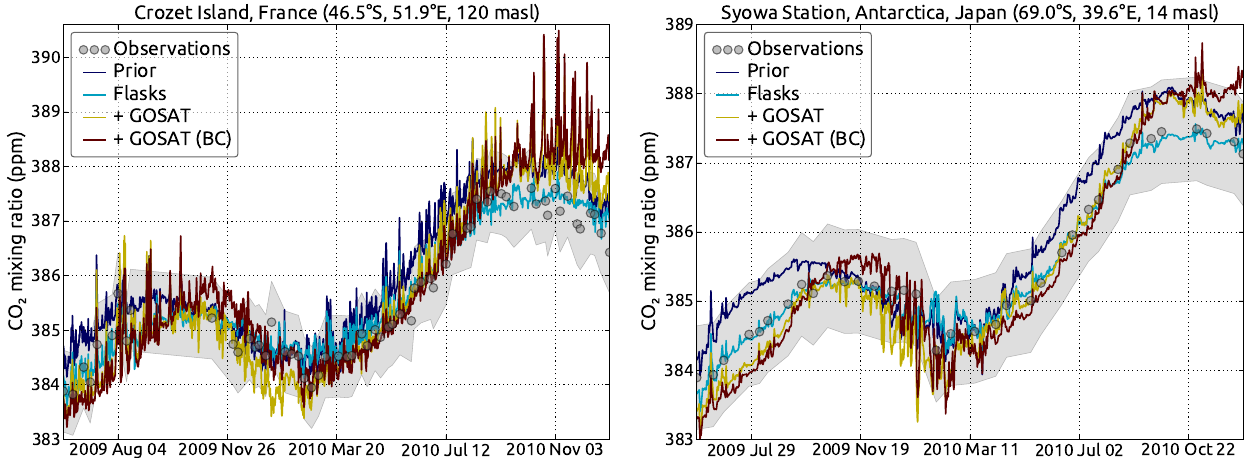
Fig. 14. The prior and posterior CO 2 time series at the same two southern extra-tropical stations as shown in Fig. 4. The inversion labeled “+ GOSAT (BC)” is a joint inversion in which a land–ocean bias in GOSAT X CO data has been optimized for, whereas the inversion labeled 2 “+ GOSAT” is a joint inversion without any bias correction. The optimized CO 2 time series at the surface in the SH extra-tropics from “+ GOSAT (BC)” has a lower seasonal cycle amplitude compared to “+